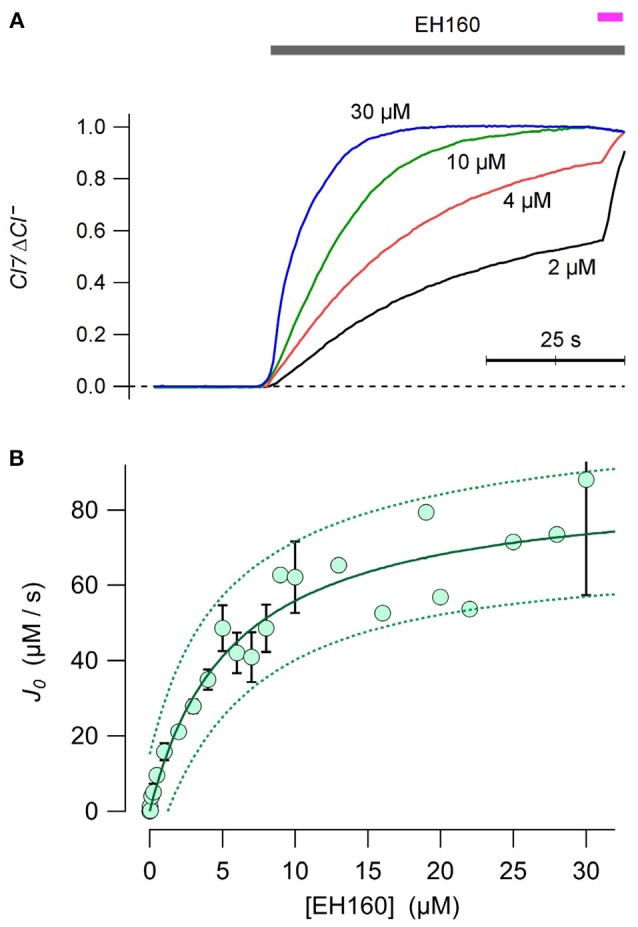
(A) Time course of external concentration of chloride elicited by various concentrations of EH160, as shown near each trace. Application of the anionophore is indicated by the upper horizontal bar, and the addition of detergent is indicated by the magenta bar. Data was normalized by the maximum anion change, ΔCl−. (B) The initial chloride efflux rate, J0 is plotted against the anionophore concentration. When the measurement was repeated more than once, data represent the average and the bar is the standard error of the mean. The continuous line is the best fit of data with equation 3, yielding the concentration for the half of the maximum effect, EC50 = 5.6 μM, and a maximum chloride initial efflux rate of 87.3 μmoles/s. Broken lines represent the prediction interval for 95% confidence.